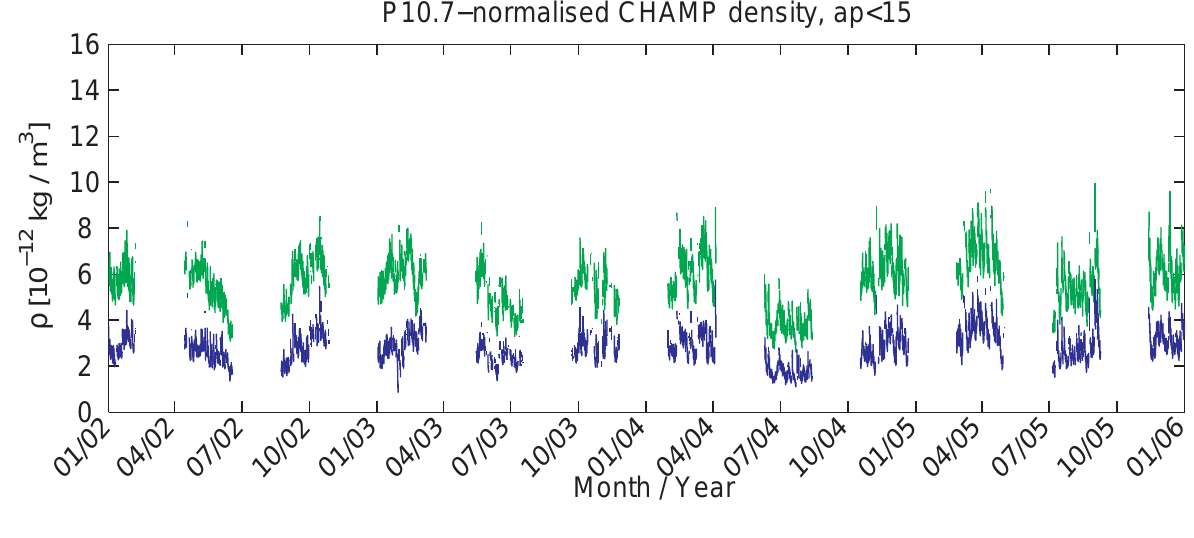
Fig. 7. Density variations in the day (green) and night (blue) time sector after normalisation to a constant solar flux level of P10.7 = 130. Only quiet 3-h intervals have been considered ( a p < 15).